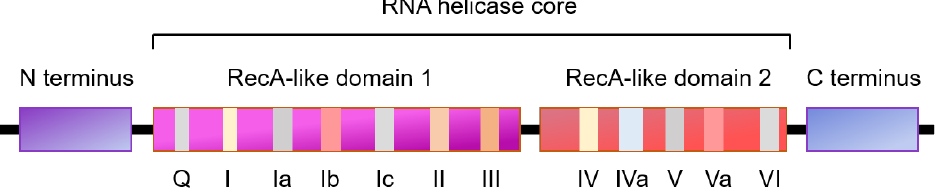
Figure 2. The sequence motifs of DEAD-box RNA helicases family are conserved. The DEAD-box RNA helicases family is characterized by a minimum of 12 conserved domains to form the DEAD- box helicase core, which consists of two RecA-related domains. Domain I and II contains 7 and 5 sequence motifs, respectively. The motifs of Q, I, II, and VI function as ATP binding and hydrolysis, and the motifs of Ia, Ib, Ic, IV, IVa, and V function as RNA binding. The motifs III and Va function as coordination between RNA and ATP binding. Domain II includes the DEAD motif (asp-Glu-ala-asp). The DEAD-box RNA helicases usually contain N and C terminal extensions, which determine their interaction with specific RNA and/or protein.